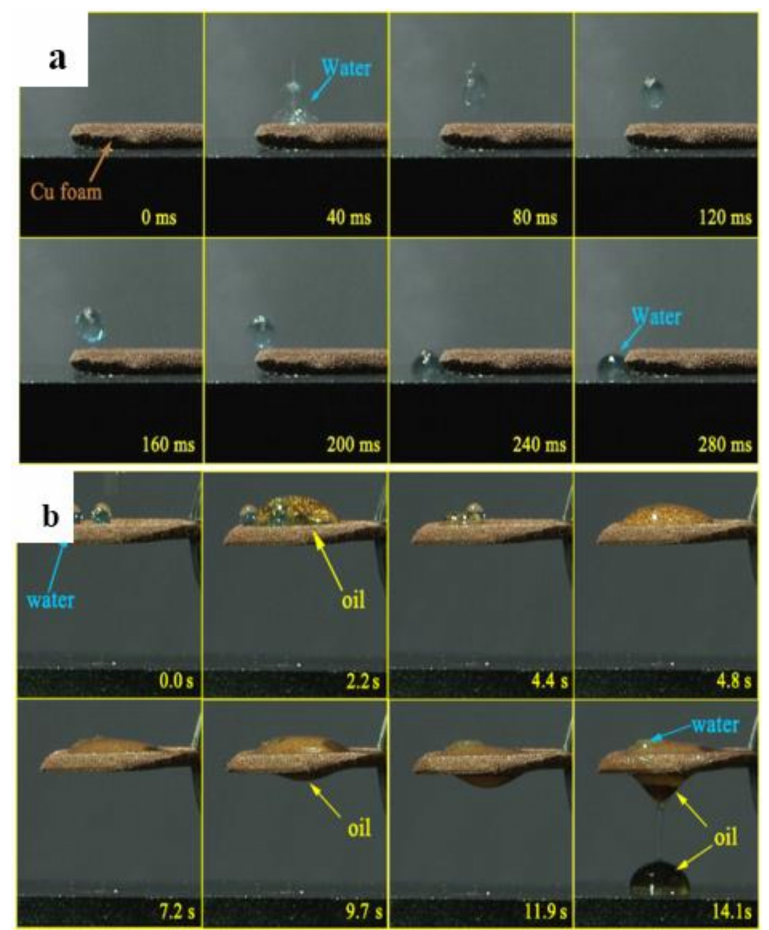
Figure 4. A series of snapshots showing a droplet of water bouncing and oil penetrating on the prepared copper foam. ( a ) Bouncing process of a water droplet. ( b ) Penetrating process of an oil droplet. Snapshots of a water droplet impacting a superhydrophobic copper foam surface. The snapshots were obtained using a high-speed camera. The water droplet and gasline engine oil continually falls freely from a height of H = 6 cm and 8 cm, respectively. The volumes of each water droplet and gasline engine oil is 50 µ L, respectively.